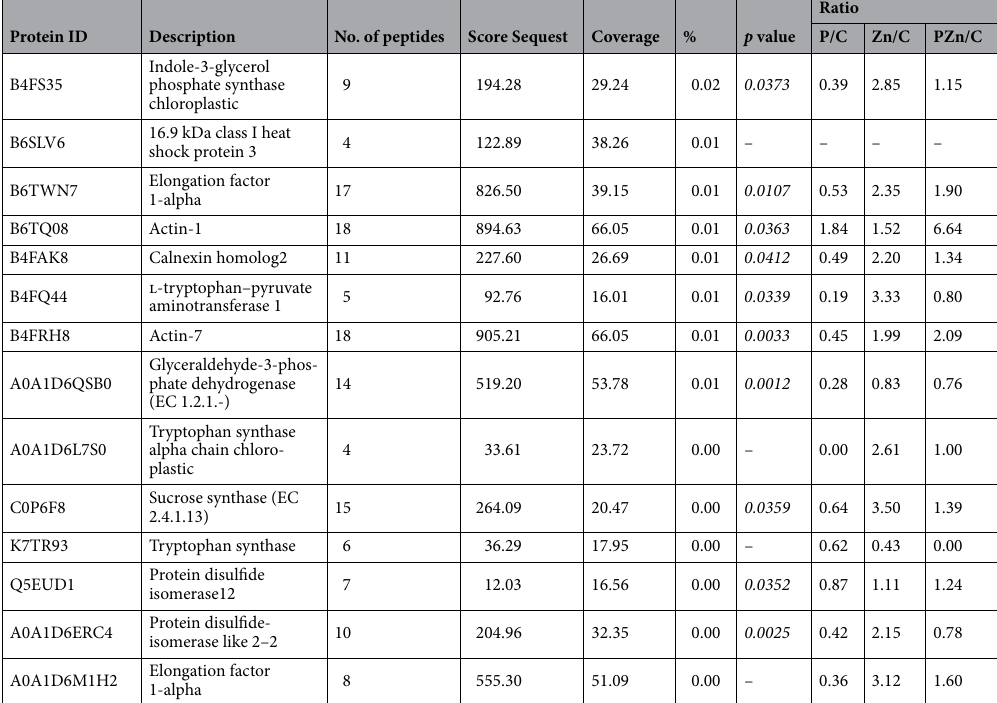
P , Zn and PZn plants, respectively (Fig. 2D). The PCA on the grain proteomic profile separated each treatment and allowed all biological replicates to be grouped (Fig. 2E). PC1 explained 70.3% of the variance and suggested differences between treatment Zn and all others. On the other hand, PC2 explained 11.3% of the variance and suggested differences between C and the treatments including nutrients. Based on the Uniprot-GO annota- tions (Table S5), most DAPs involved in biological processes were translation, folding or refolding proteins. By contrast, most DAPs performing molecular functions were ATP binding, RNA binding or ribosomal structural constituent proteins. On the other hand, the proteins belonging to cellular components were mainly associated to the cytoplasm, cytosol or nucleus. Molecular function analysis revealed that the major pathways were protein synthesis (28%), RNA synthesis (5.54%), amino acid metabolism (5.54%) and stress response (5.29%) (Fig. S3). A total of 13 proteins (6 zeins, 5 globulins, 1 albumin and 1 glutelin) were maize grain storage proteins (Table 4, Table S4). Two globulins (Q7M1Z8 and P15590), and one zein (A0A1R3QMY2,) differed significantly ( p < 0.05) between treatments (Table 4). Also, one globulin (A0A1D6KYZ7) and one zein (P04701) were qualita- tive DAPs (Table 4). Relative to C plants, Q7M1Z8 was down-accumulated in P , P15590 up-accumulated in Zn but down-accumulated in P , A0A1R3QMY2 up-accumulated in PZn , P04701 up-accumulated in PZn but down- accumulated in Zn , and A0A1D6KYZ7 was only present in Zn and down-accumulated in P and PZn (Table 4). Two DAPs were trp-rich proteins and 24 lys-rich proteins (Table 4). Three of the trp-rich proteins were up- accumulated in Zn but down-accumulated in P ; also, one was down-accumulated in both Zn and PZn (Table 4, Table S4). In the lys-rich protein group, 53% were up-accumulated in Zn , 60% down-accumulated in P , 23% up-accumulated in PZn and 10% down-accumulated in the same treatment (Table 4).